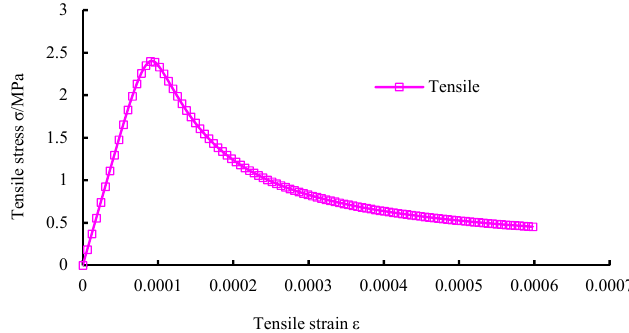
Figure 4. Stress-strain curve of concrete under tension.